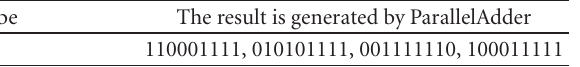
Table 1: Result of tube T 0